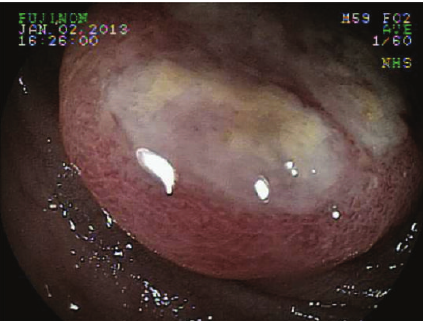
Figure 3: High magnification of the tissue biopsy showing irregular nuclear borders, condensed chromatin, and numerous atypical mitoses.